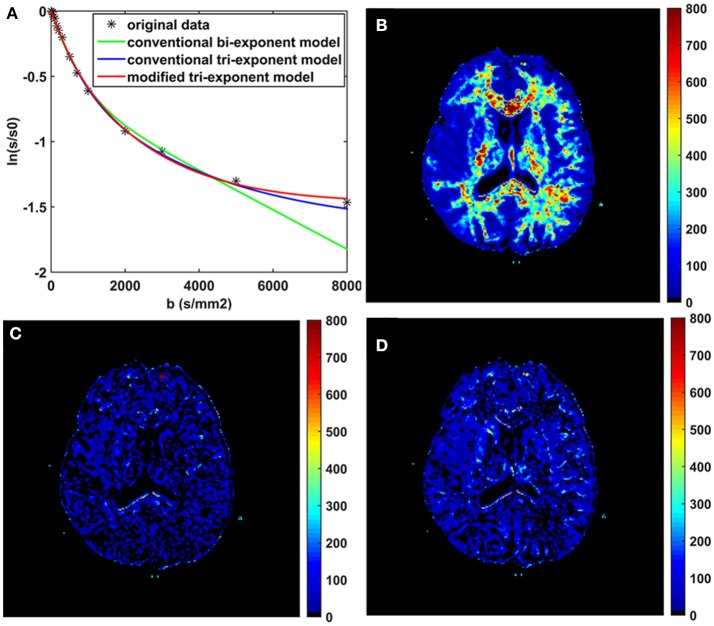
The fitting curves of the three models with the first 16 b-values in a typical voxel of white matter (A). The maps of the squared prediction errors (SPE) calculated by the bi-exponential model (B), the conventional tri-exponential model (C), and the modified tri-exponential model (D). The unit for SPE is ×10−5.